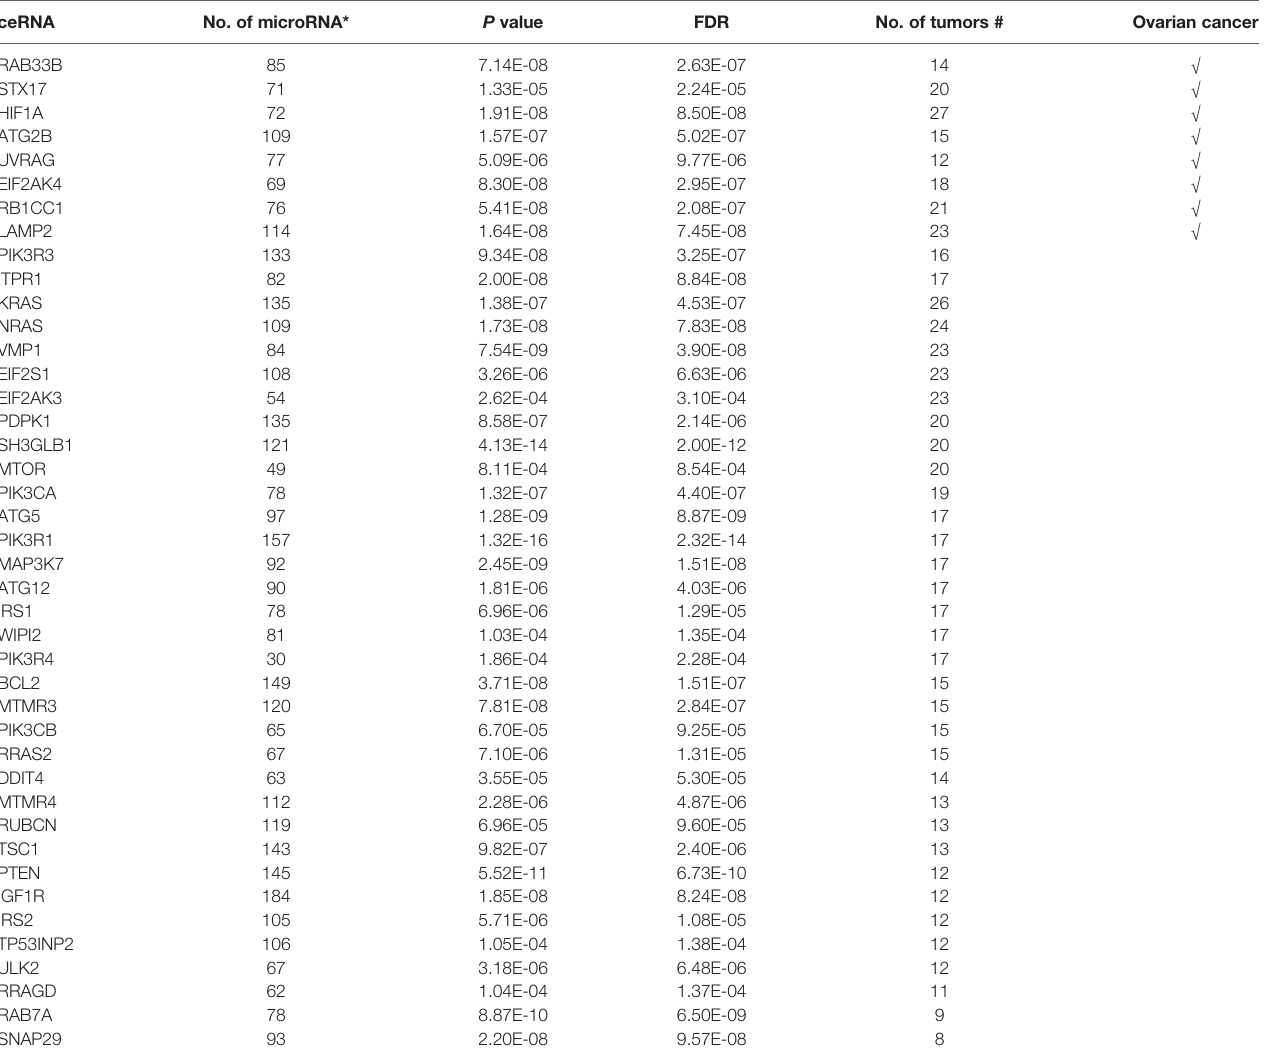
*Number of microRNAs that SLC7A11 interacted with the autophagy gene as a ceRNA. # Number of tumor types that SLC7A11 potentially regulate the autophagy gene as a